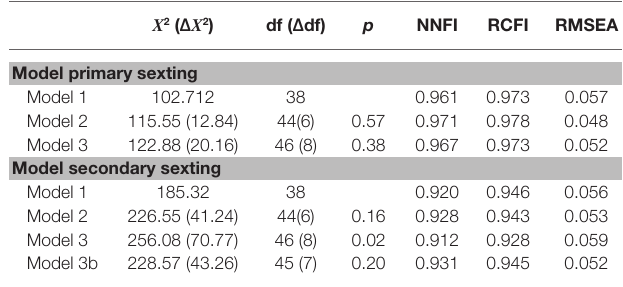
Model 1: Configural invariance. Model 2: Measurement invariance (equal factor loadings). Model 3: Structural model invariance (equal factor loadings, factor variances, and covariances). Χ 2 , Chi square statistic; df, degrees of freedom; NNFI, non-normed fit index; RCFI, robust comparative fit index; RMSEA, root mean-square error approximation.